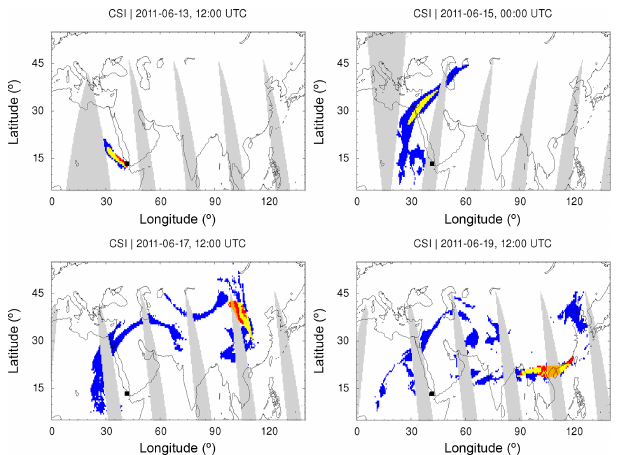
Figure 3. Same as Fig. 2, but for a unit simulation initialized at 29km altitude. This simulation almost immediately disagrees with the satellite observations. Note that the time steps are partly differ- ent from those shown in Fig. 2.